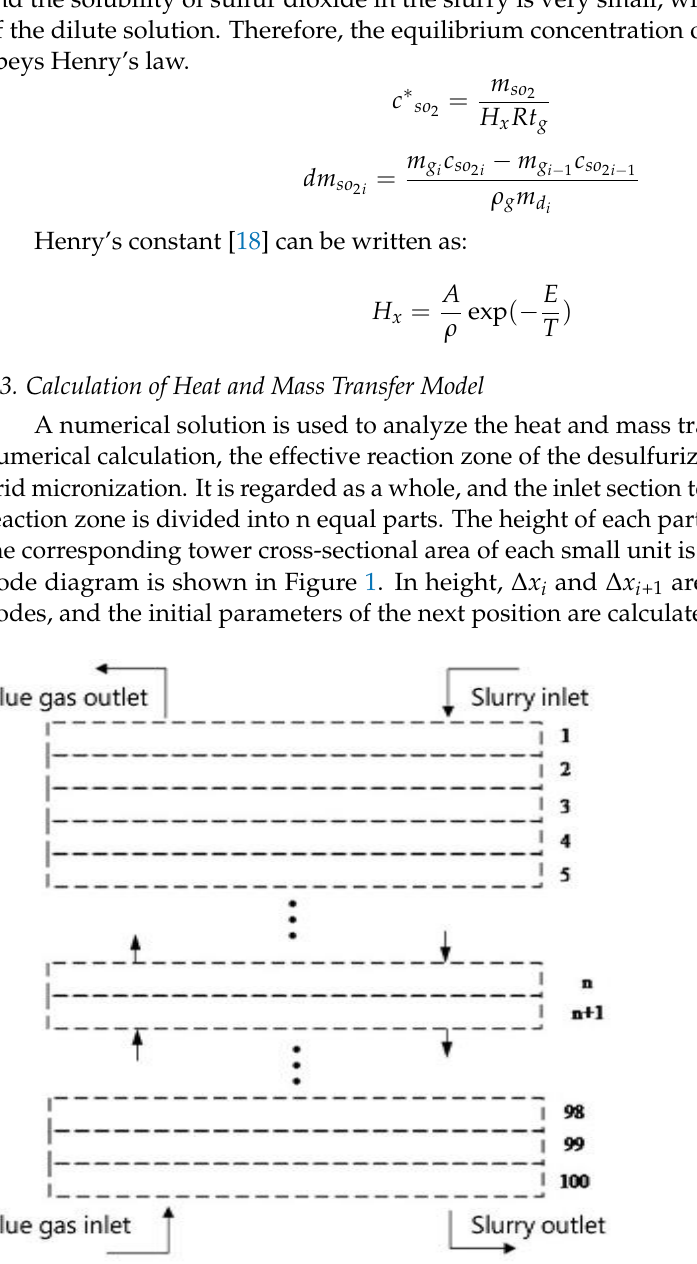
Figure 1. Numerical calculation schematic diagram of desulfurization tower.